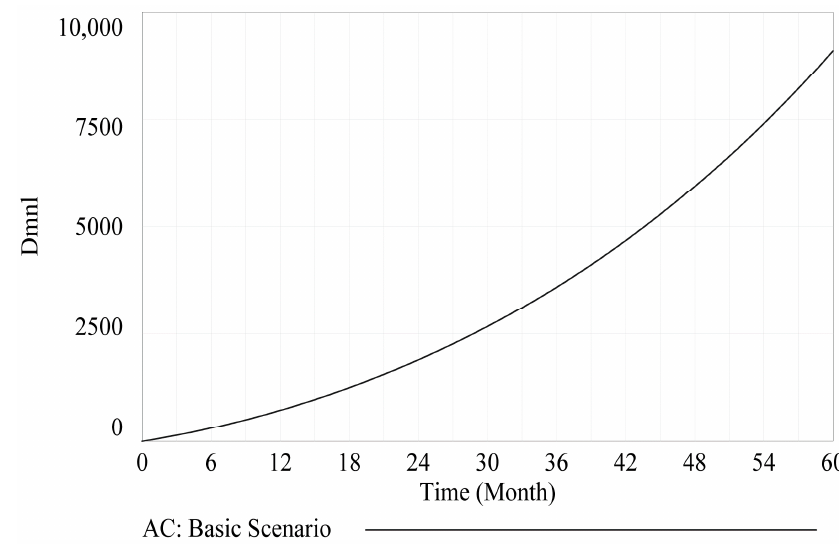
Figure 4. Evolution of AC under the basic scenario.